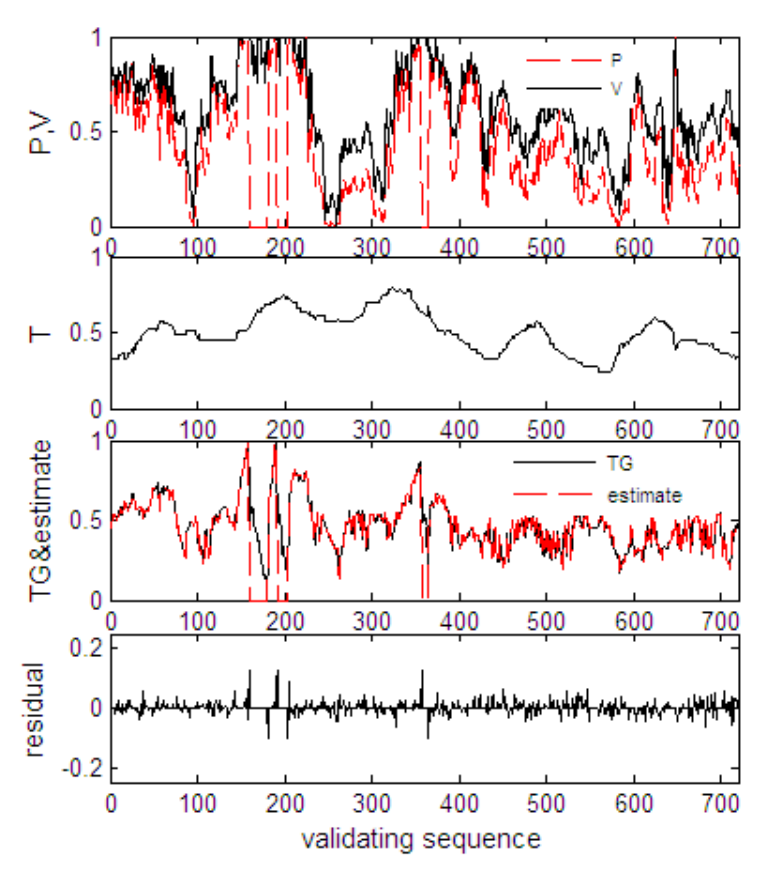
Figure 8. Validation results for the AAKR